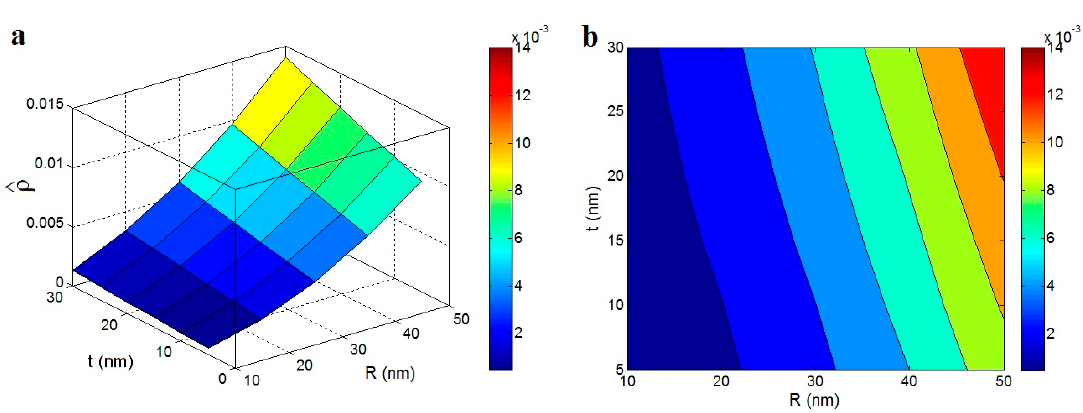
Figure 8. The roles of nanoparticles and interphase dimensions in the relative density of the network by “ φ p ” predictions of Equation (7) at φ f = 0.02, l = 5000 nm and n = 100: ( a ) 3D and ( b ) contour